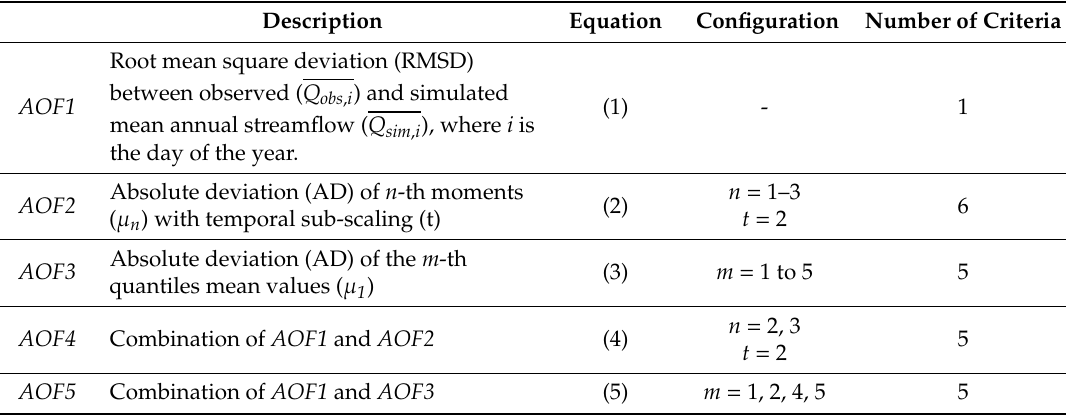
Table 1. Description and configuration of asynchronous objective functions